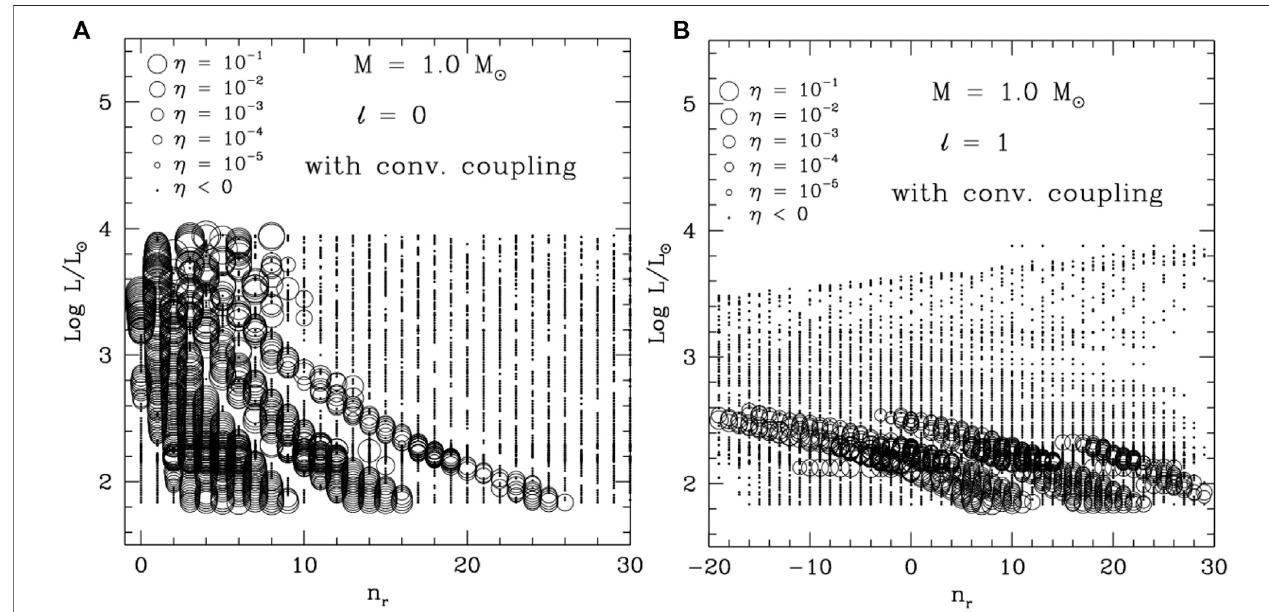
FIGURE 7 | (A) Pulsationally stable (small fi lled circles) and unstable (open circles) radial modes on the log L / L ⊙ − n r plane for evolutionary AGB models of M (cid:2) 1 . 0 M ⊙ .Thesizeoftheopen circlesareproportionaltothelogarithmofamplitudegrowth rate. (B) Thesameas (A) but forlow-degree ( l (cid:2) 1 ) non-radialmodes. The abscissa n r (cid:2) n p − n g is the radial order; n p and n g are, respectively, the node number for p- and